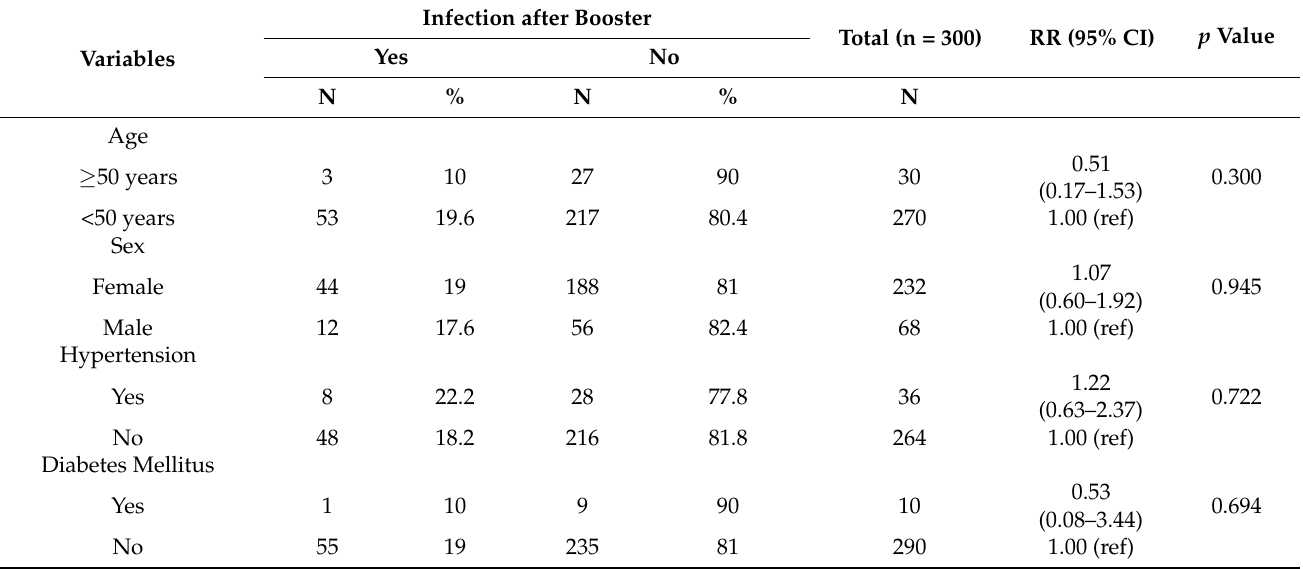
Figure 3. COVID-19 events within 5 months of the booster vaccination (n = 56). As seen in this figure, there was a substantial increase in COVID-19 cases among the 300 subjects between December 2021 and February 2022. This is in line with the third wave of COVID-19 in Indonesia.